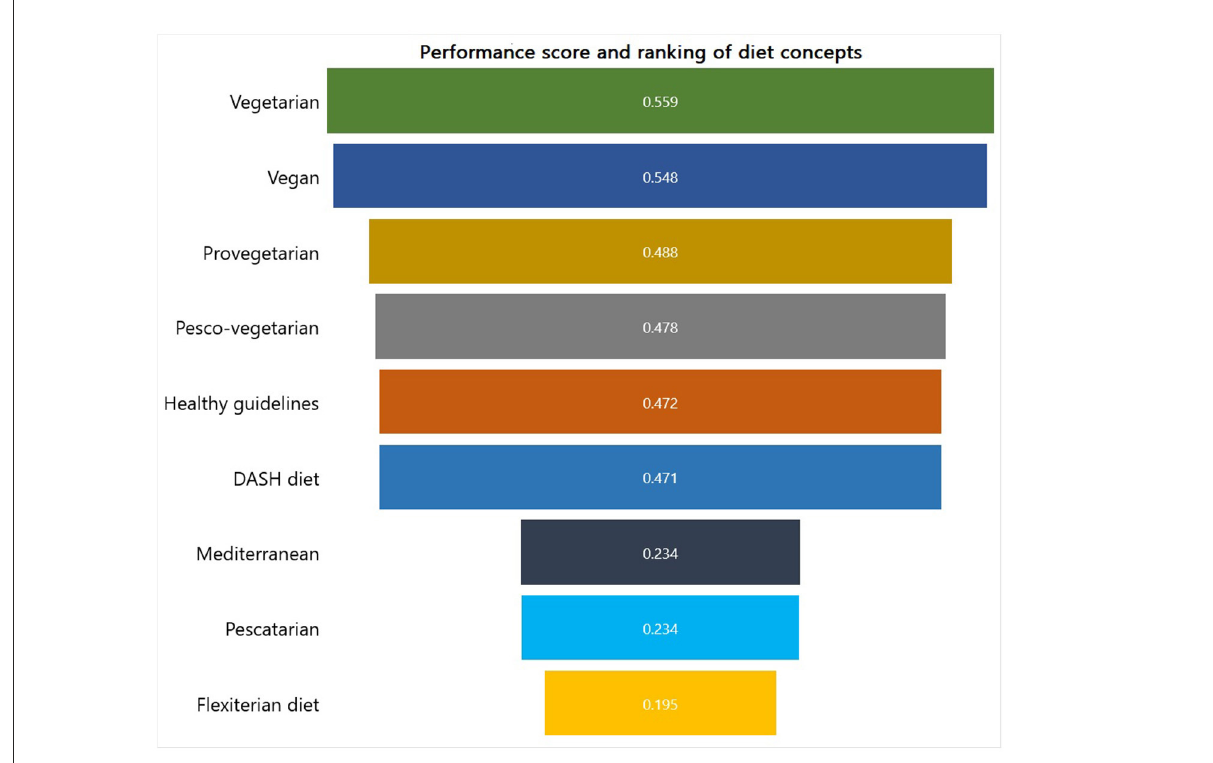
FIGURE10 Ranking of dietary concepts using the TOPSIS